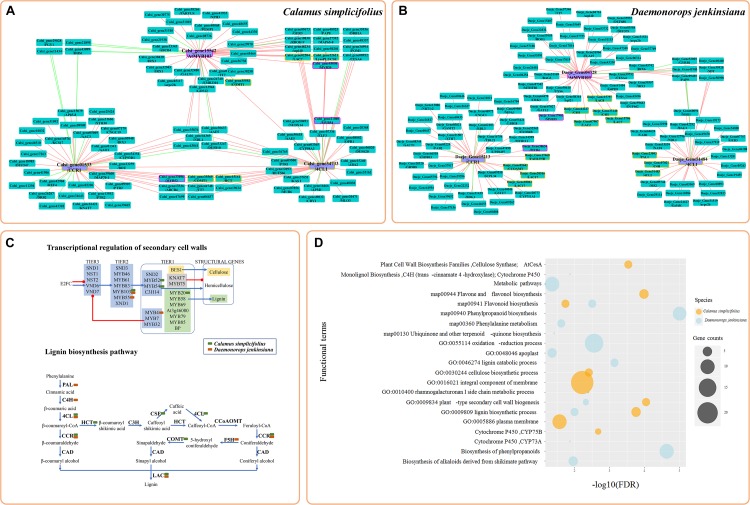
Coexpression network analysis of the genes involved in secondary cell wall biosynthesis in rattans. (A) The coexpression network (CEN) of Calsi_gene34733 (4CL1), Calsi_gene01533 (CCR1), and Calsi_gene15542 (MYB103) in C. simplicifolius. (B) The CEN of Daeje_Gene51484 (4CL1), Daeje_Gene15213 (CCR1), and Daeje_Gene04728 (MYB103) in D. jenkinsiana.
(A,B) The red and green lines link the positive and negative coexpression gene pairs, respectively. The rectangles with purple and yellow borders represent gene families involved in the transcriptional regulation of secondary cell walls (SCWs) and the lignin biosynthesis pathway, respectively. (C) Transcriptional regulation of SCW and lignin biosynthesis pathways (Kumar et al., 2016). The green and orange blocks indicate genes in the coexpression network of (A,B), respectively. Transcription factors (TFs) involved in SCW biosynthesis can be broadly classified into three groups. Tier 1 TFs bind directly to the structural genes responsible for the biosynthesis of cell wall components. Tier 2 TFs can regulate Tier 1 TFs in addition to structural genes, whereas Tier 3 TFs can regulate Tier 2 TFs and the structural genes. The blue arrows indicate positive regulation, whereas the red lines indicate negative regulation. Groups of TFs are shaded as follows: light green, lignin; light yellow, cellulose; others, light blue. The simplified pathway represents the most common pathways for the biosynthesis of lignin units. (D) GSEA results of coexpressed genes in (A,B). The gene sets of GO, KEGG, and Gene Families (GFam) were selected.